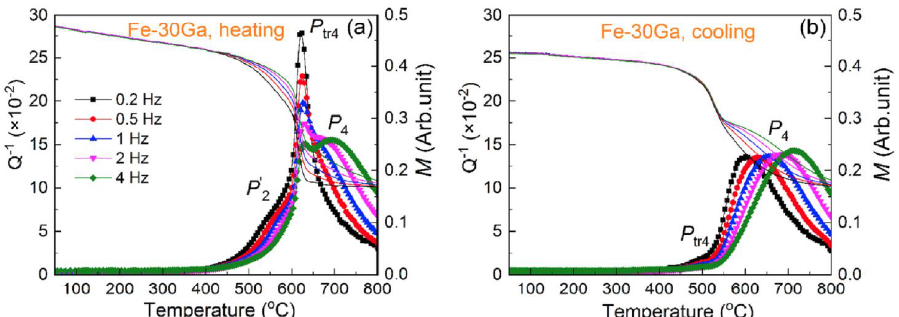
Figure 26. TDIF curves and relative modulus–temperature curves in continuous heating ( a ) and cooling ( b ) processes for 480 °C; 14 days annealed Fe–30Ga sample at 5 different frequencies of 0.2, 0.5, 1, 2, and 4 Hz [61].